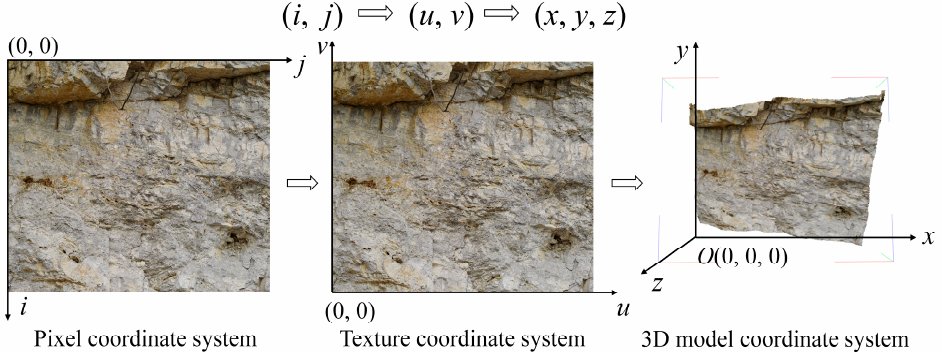
(Figure 3): (1) 2D pixel coordinates to 2D texture coordinates; (2) 2D texture coordinates to 3D model coordinates.